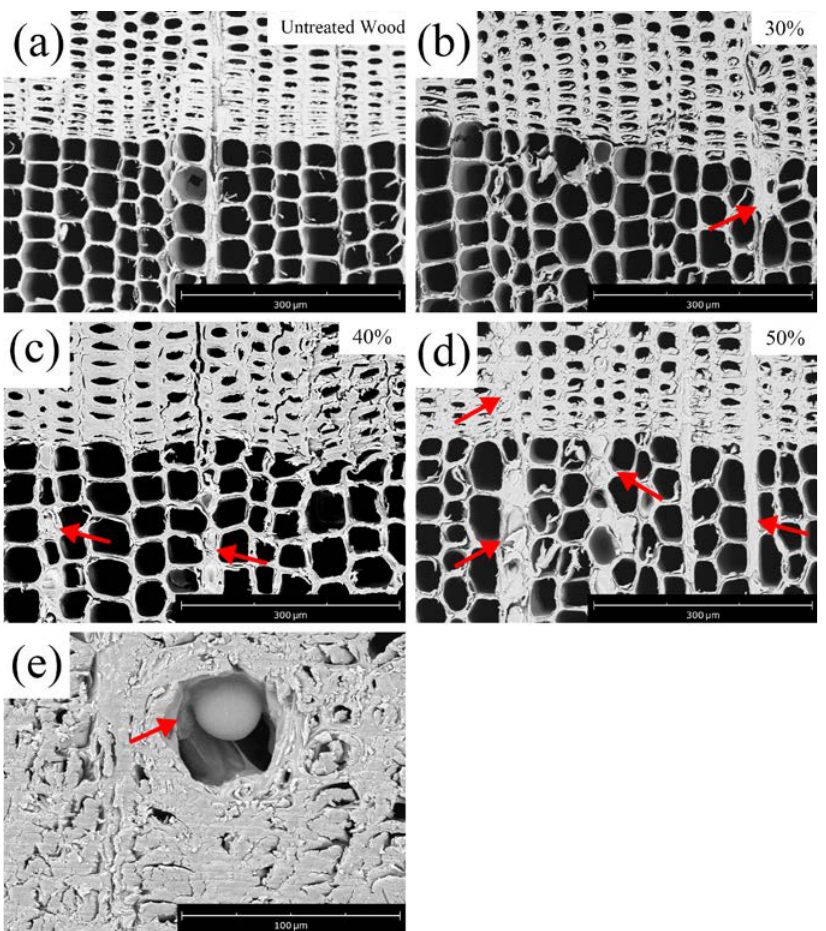
Figure 4. The cross-sectional structure of control wood ( a ), furfurylated wood ( b – d ), and resin canal ( e ) in SEM. The arrows show the deposition of PFA.